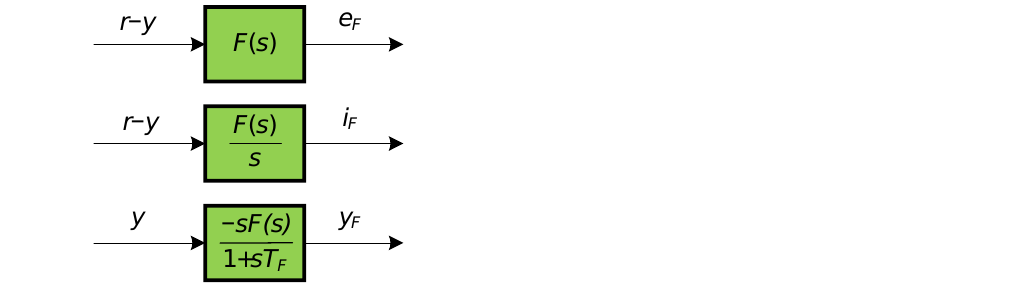
Figure 7. Filtering of input ( u ) and output ( y ) signals to obtain additionally filtered regression signals e F , i F and y F , where r = K PR u.